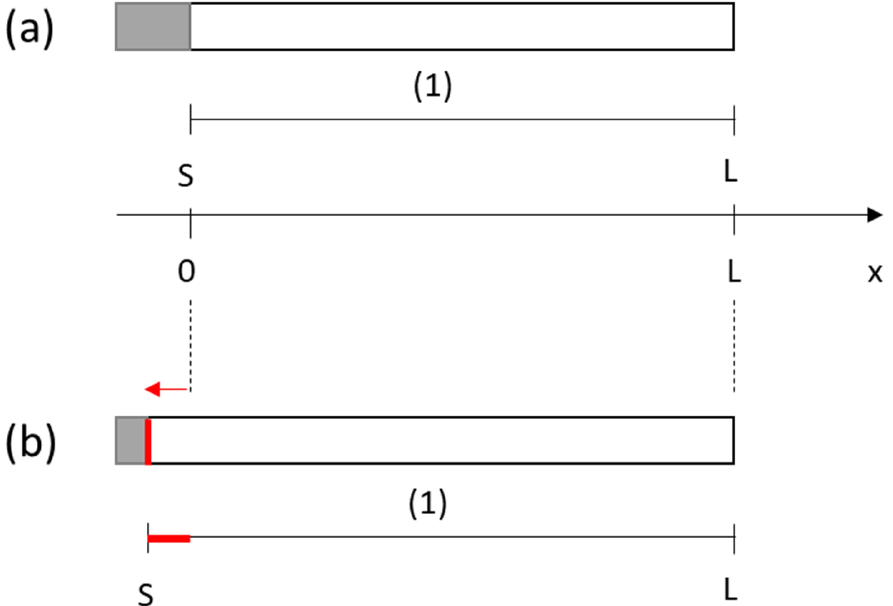
Figure 2. Schematic representation of the dissolution of the lead test tube immersed in a deaerated HCl solution. ( a ) at t0 and ( b ) at t.